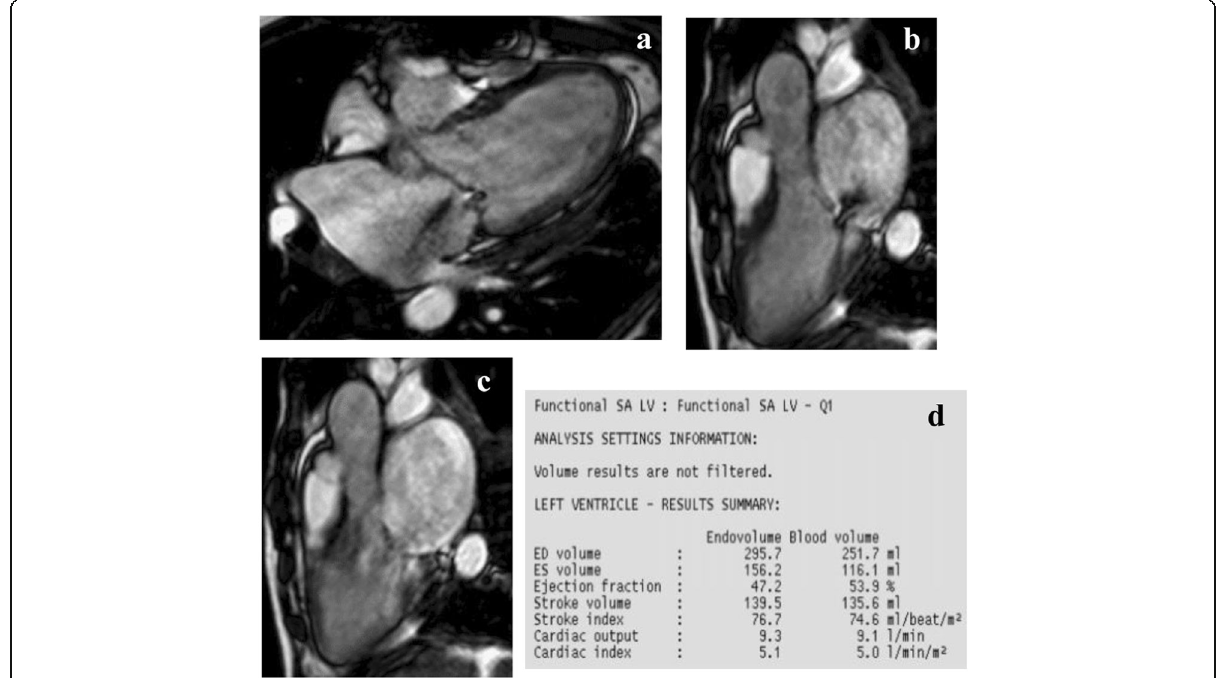
Fig. 4 A 51-year-old male patient with rheumatic valvular heart disease presented with dyspnea and lower limb edema. The performed CMR showed mitral and aortic regurge. Mitral regurge is seen in a four-chamber view during systole and b three-chamber view during systole, and aortic regurge is seen in c three-chamber view during diastole; d the volumetric analysis shows that ejection fraction estimated by volumetric short-axis method (EFvol) was 47.2% (mild